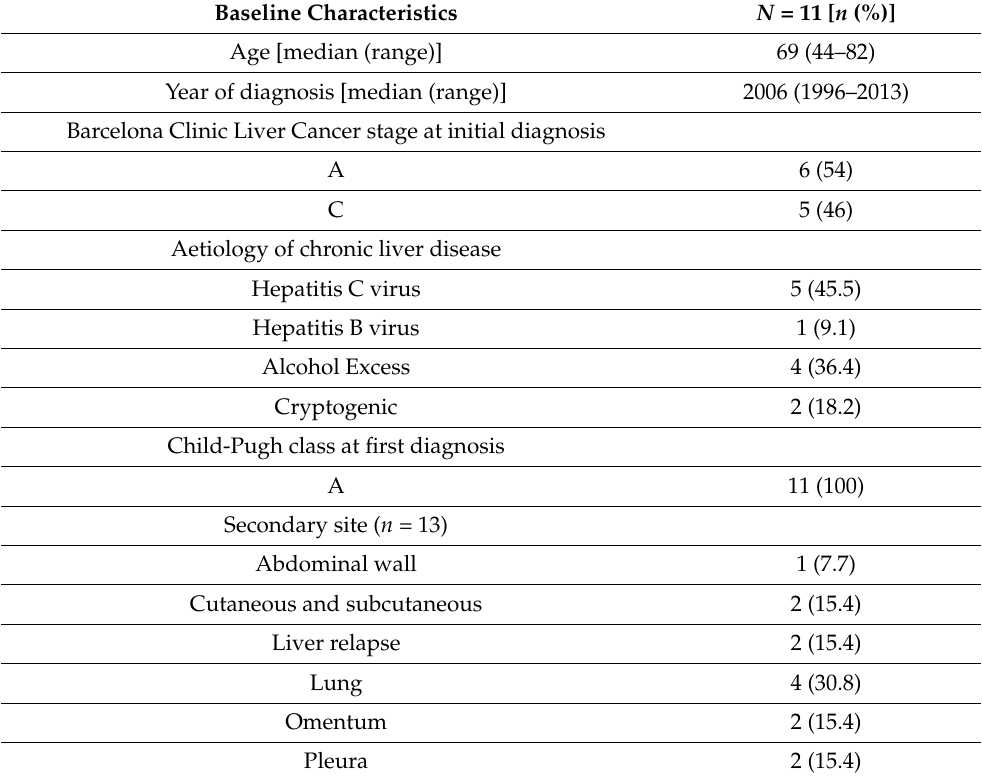
Table 1. Patient